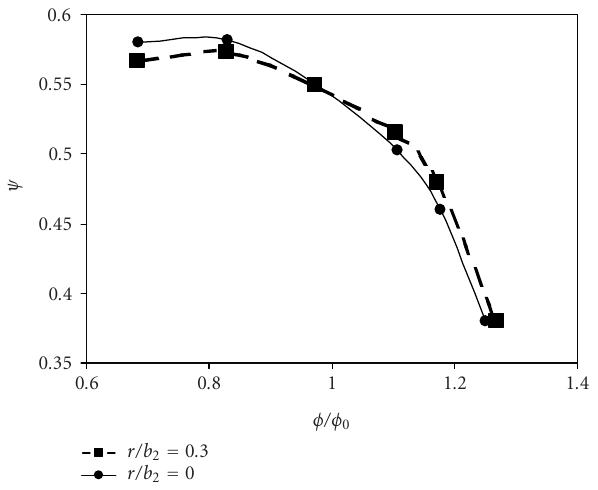
Figure 12: The performance characteristics of the two volute con- figurations discussed. The tradeo ff between peak performance of the sharp tongue and the greater range of the round tongue is evi-